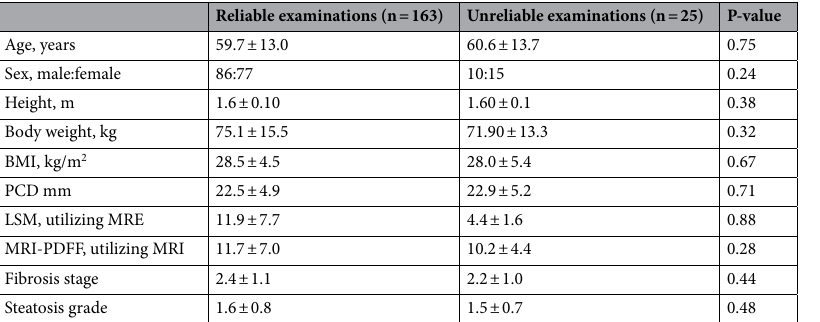
Table 3. Factors that may influence the implementation of reliable VCTE. Data are presented as means ± standard deviations. BMI body mass index, LSM liver stiffness measurement, MRE magnetic resonance elastography, MRI magnetic resonance imaging, MRI-PDFF magnetic resonance imaging-proton density fat fraction, PCD probe to liver capsule distance. *P <